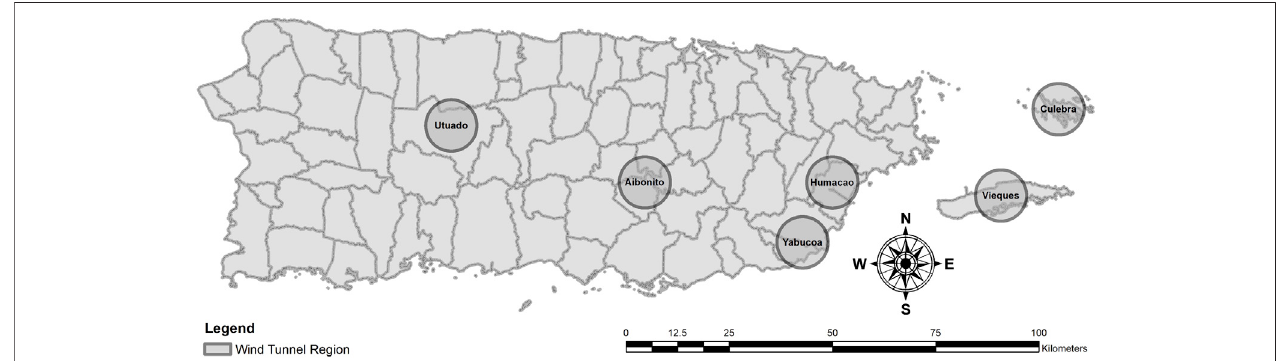
FIGURE 1 | Regions of Puerto Rico selected for testing at BLWT at